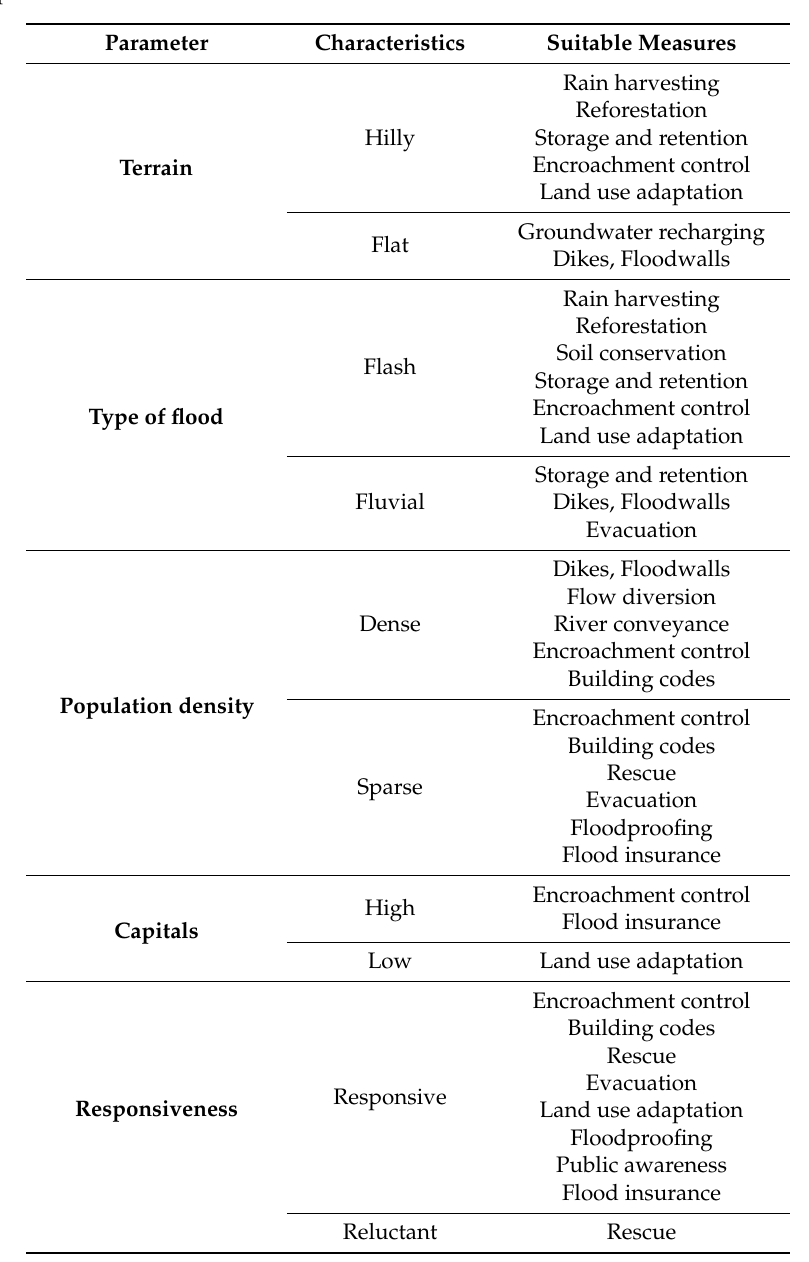
Table 1. A practical example of flood management options and priorities for di ff erent characteristics of the